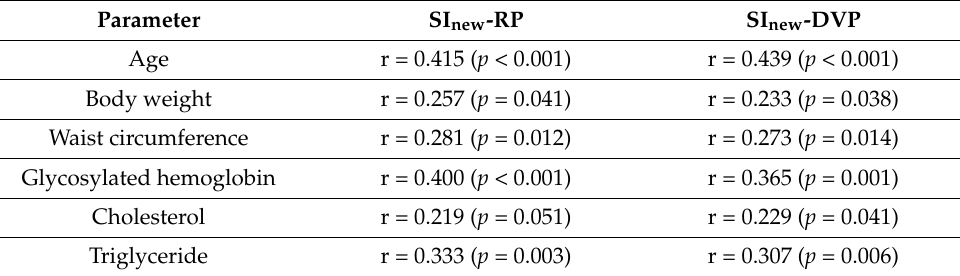
Table 4. Correlations between SI new -RP/SI new -DVP and age, body weight, waist circumference, glycosylated hemoglobin, cholesterol, and